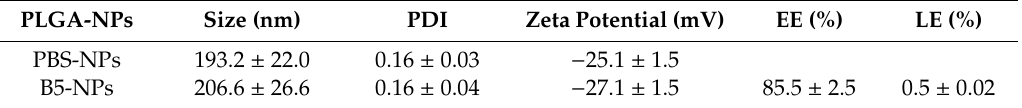
Table 1. Characterization of PLGA-NPs with sizes and surface chemistries (n =